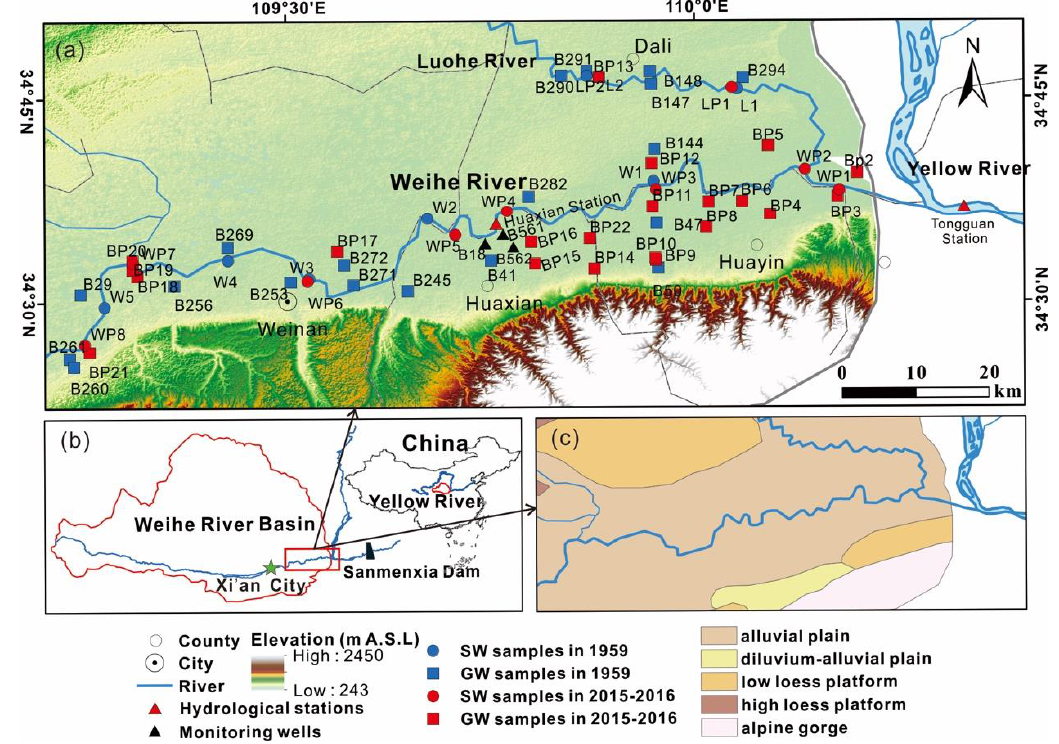
Figure 1. ( a ) Study area and relevant sampling sites; ( b ) locations of the study area and the Sanmenxia Dam; ( c ) geomorphic types in the study area.